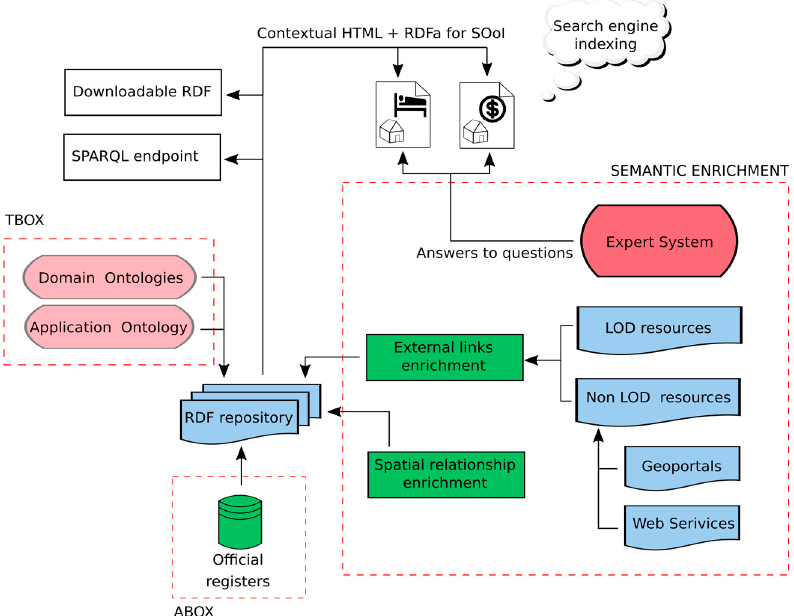
Figure 1. Concept of system architecture.